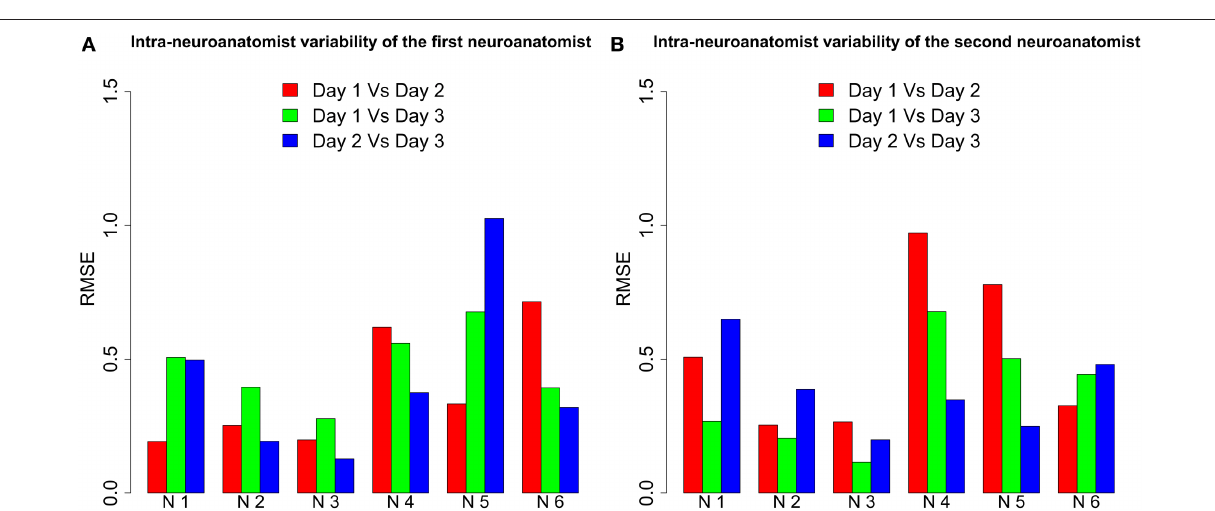
Frontiers in Neuroanatomy |